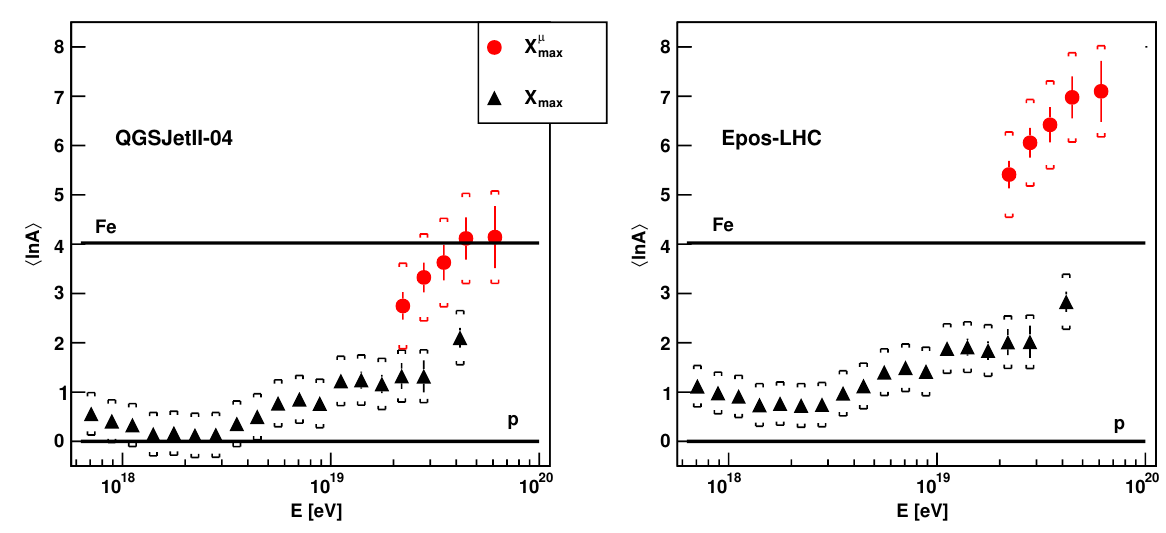
(cid:105) (red circles). The results obtained for (cid:104) X (cid:105) (black max max